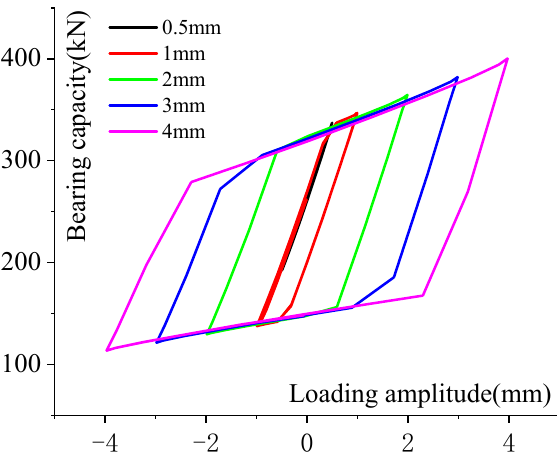
Figure 7. Hysteretic curve when changing the loading amplitude.